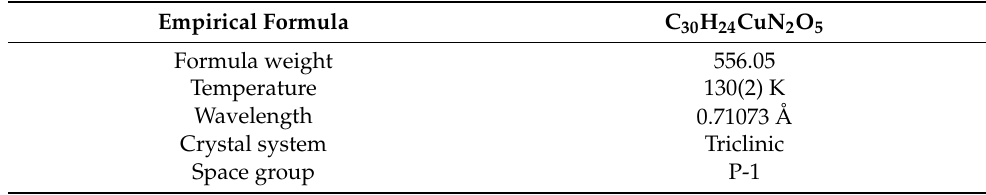
Table 1. Crystal data and structure refinement for the functional monomer [Cuphen(VBA) 2 H 2